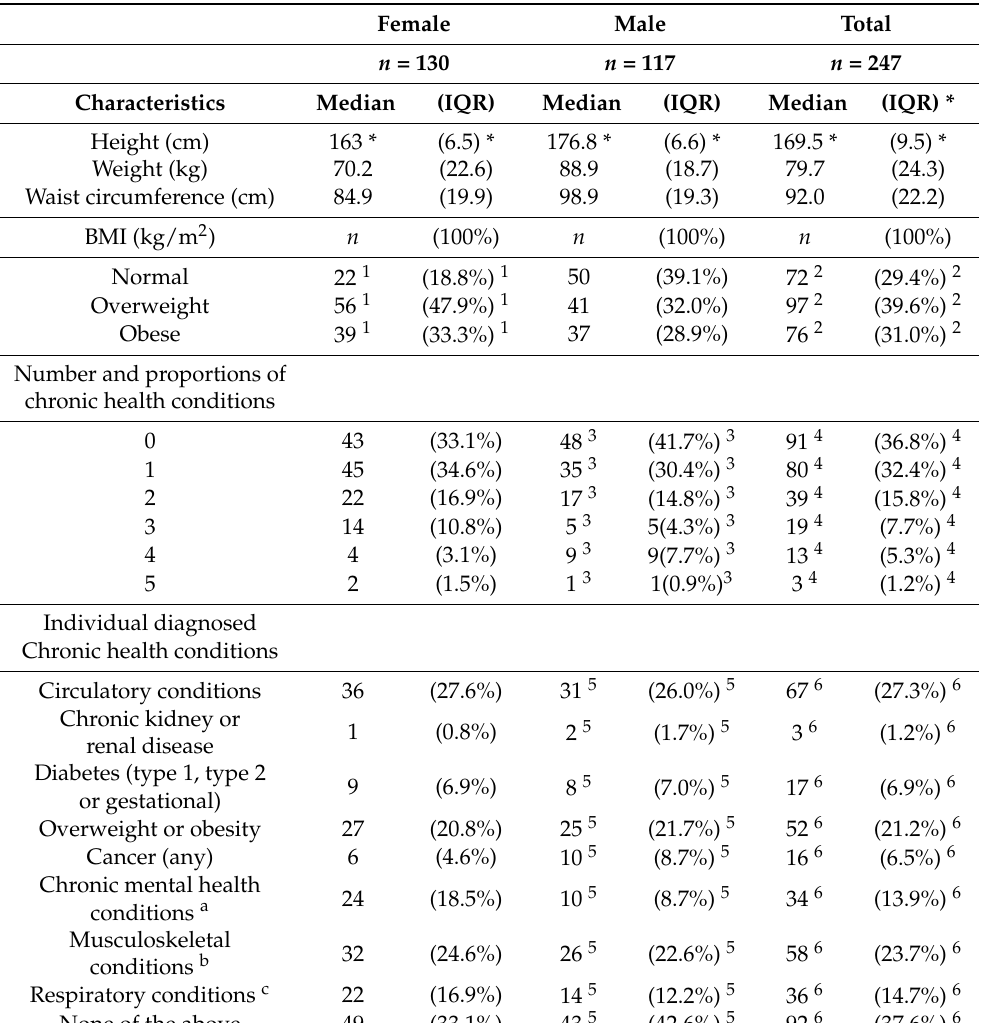
Table 2. Descriptive statistics of anthropometric characteristics, chronic health conditions and categories of BMI in the study sample of Australian